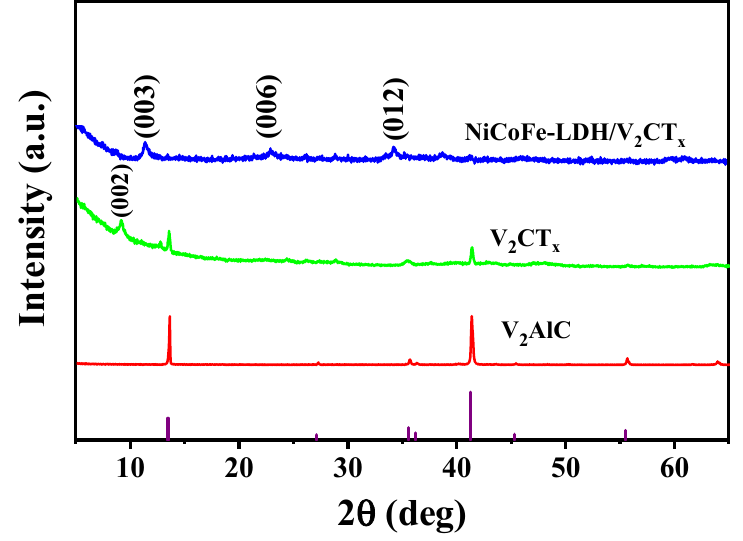
Figure 3. XRD pattern of NiCoFe–LDH/V 2 CT x .